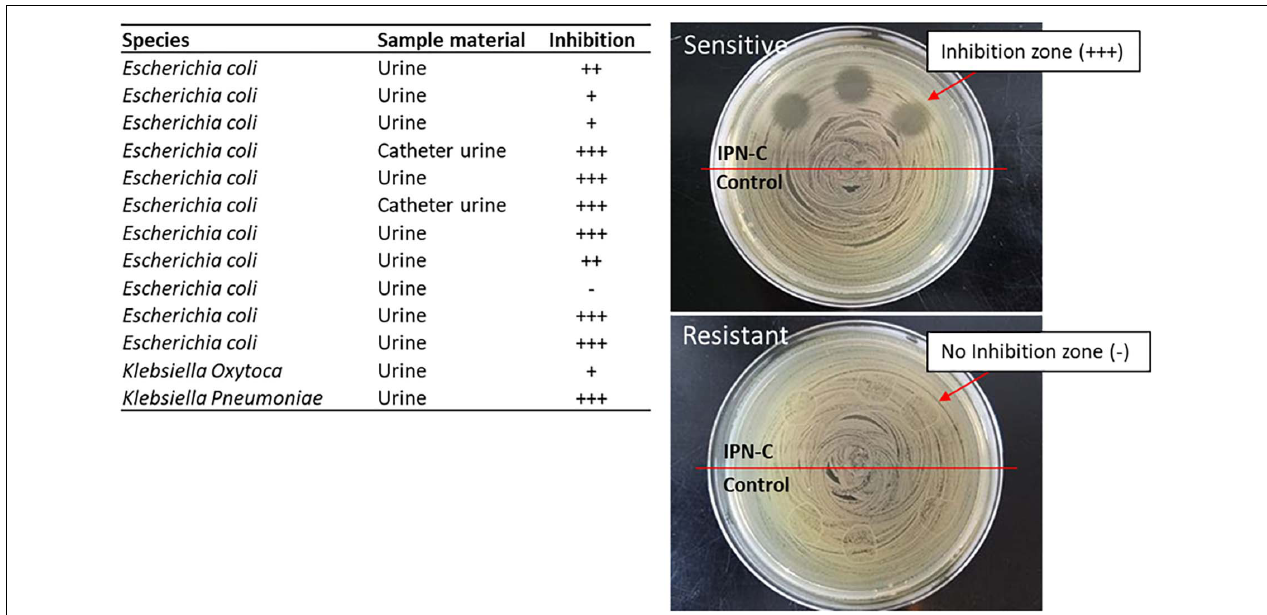
FIGURE 5 | Inhibition test of released sparfloxacin against clinical uropathogenic bacterial isolates. Aliquots (20 µ l) of NaCl from release assays (day 6) were placed on LB agar plates that had been homogeneously inoculated with clinically isolated uropathogens using a plate spreader. After ON incubation at 37 ◦ C, inhibition was graded as: no inhibition ( − ), inhibition zone with several single-colonies (+), inhibition zone with few single-colonies (++), inhibition zone with no single-colonies within the zone (+++). Sample material indicates whether the bacteria is isolated from urine samples or a catheter urine sample.